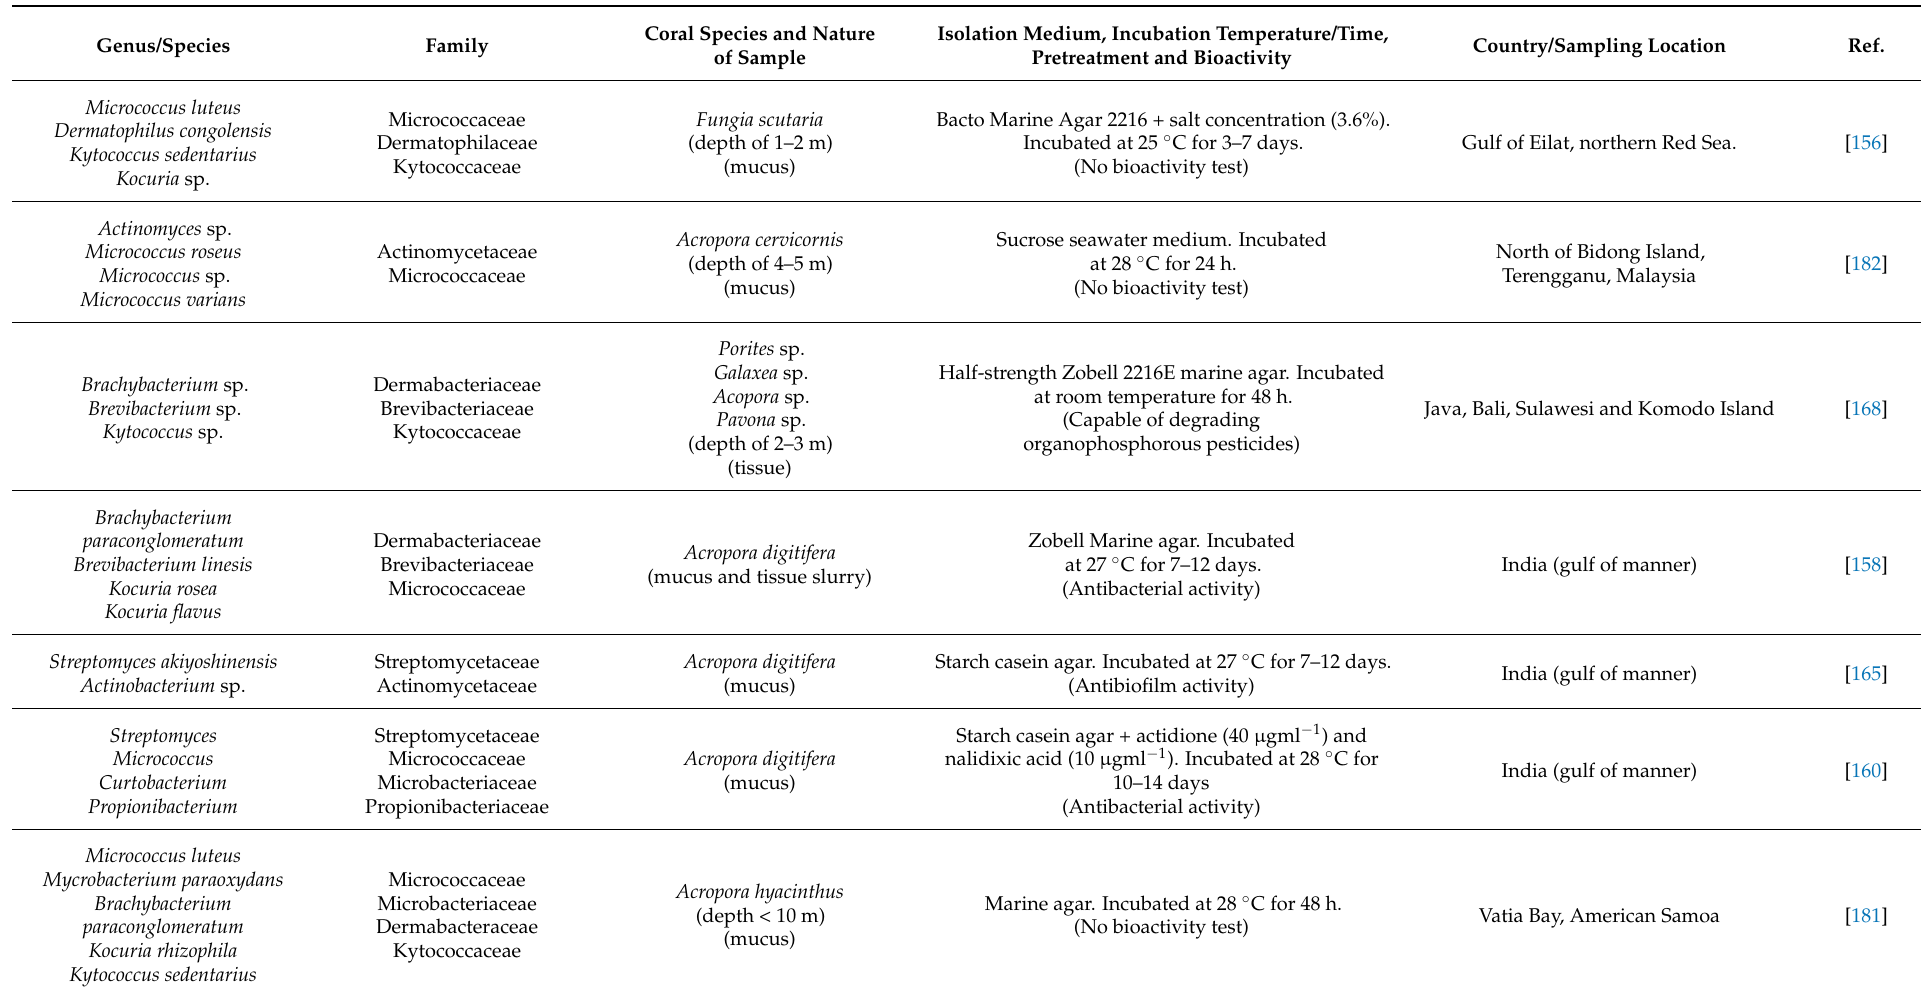
Table 1. Genus/species of Actinobacteria isolated from coral (order Scleractinia) between 2006 and 2022.